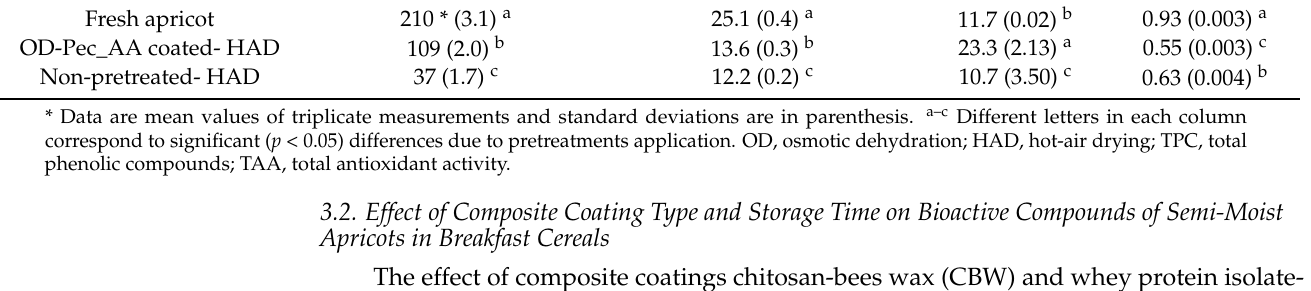
Table 1. Effect of osmotic dehydration (OD) and Pec-AA coating application prior to hot-air drying (HAD) on bioactive compounds, a w and browning value of dried apricot.